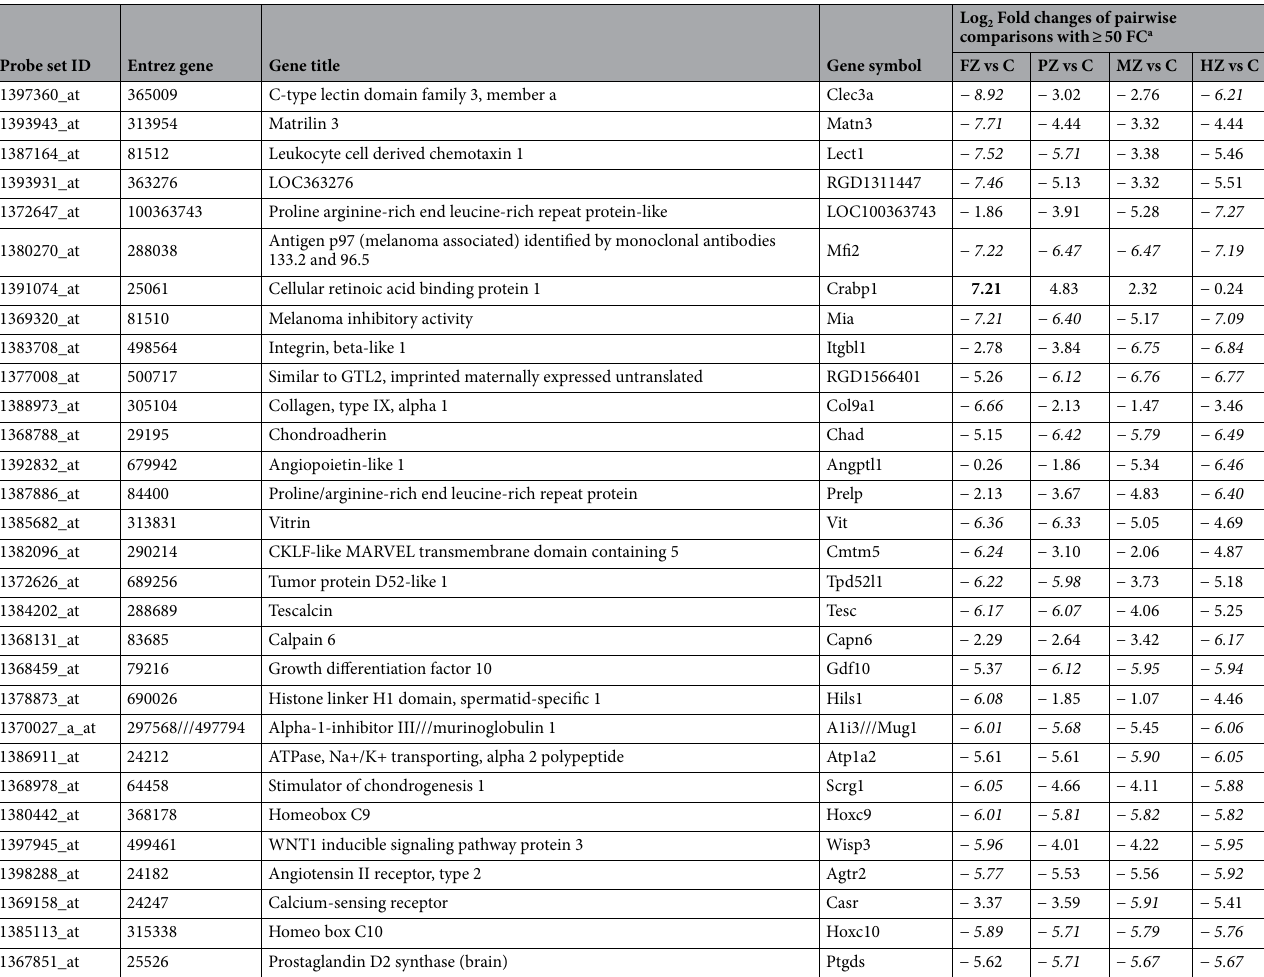
Table 2. Top 30 differentially expressed genes that showed strong modulation in at least one of the four pairwise comparisons where each MCC zone was compared to FCC (the control, C) at ≥ 50 -fold change cut-off value (log 2 50 FC = 5.64, bold and italics indicate gene upregulation and downregulation respectively above the cut-off value). a For each gene in the pairwise comparison, there were 2 normalized intensity values (one for each group) representing the expression levels. The fold change (FC) value for the gene is calculated by dividing the larger value by the smaller one, then a positive sign is assigned if the gene is upregulated, in other words the gene expression value of the sample (the first group) is greater than the reference (the second group). On the other hand, downregulation of the gene (negative sign) indicates that the gene expression value of the sample is less than the